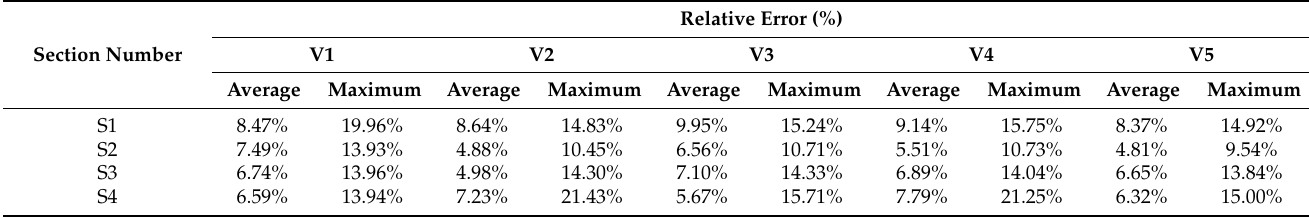
Figure 4. 3D velocity distribution and verification of each measured vertical line in Section S1–S4. ( A ) Section S1, ( B ) Section S2, ( C ) Section S3, ( D ) Section S4. Table 1. Relative error of longitudinal velocity of each vertical